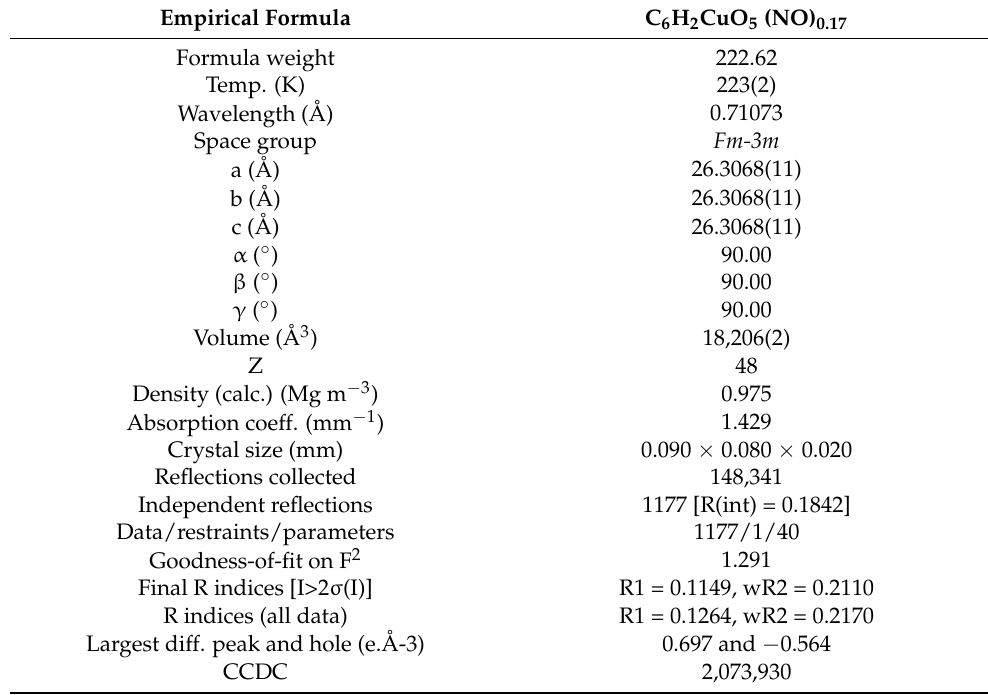
Table 1. Crystallographic data for NO ⊂